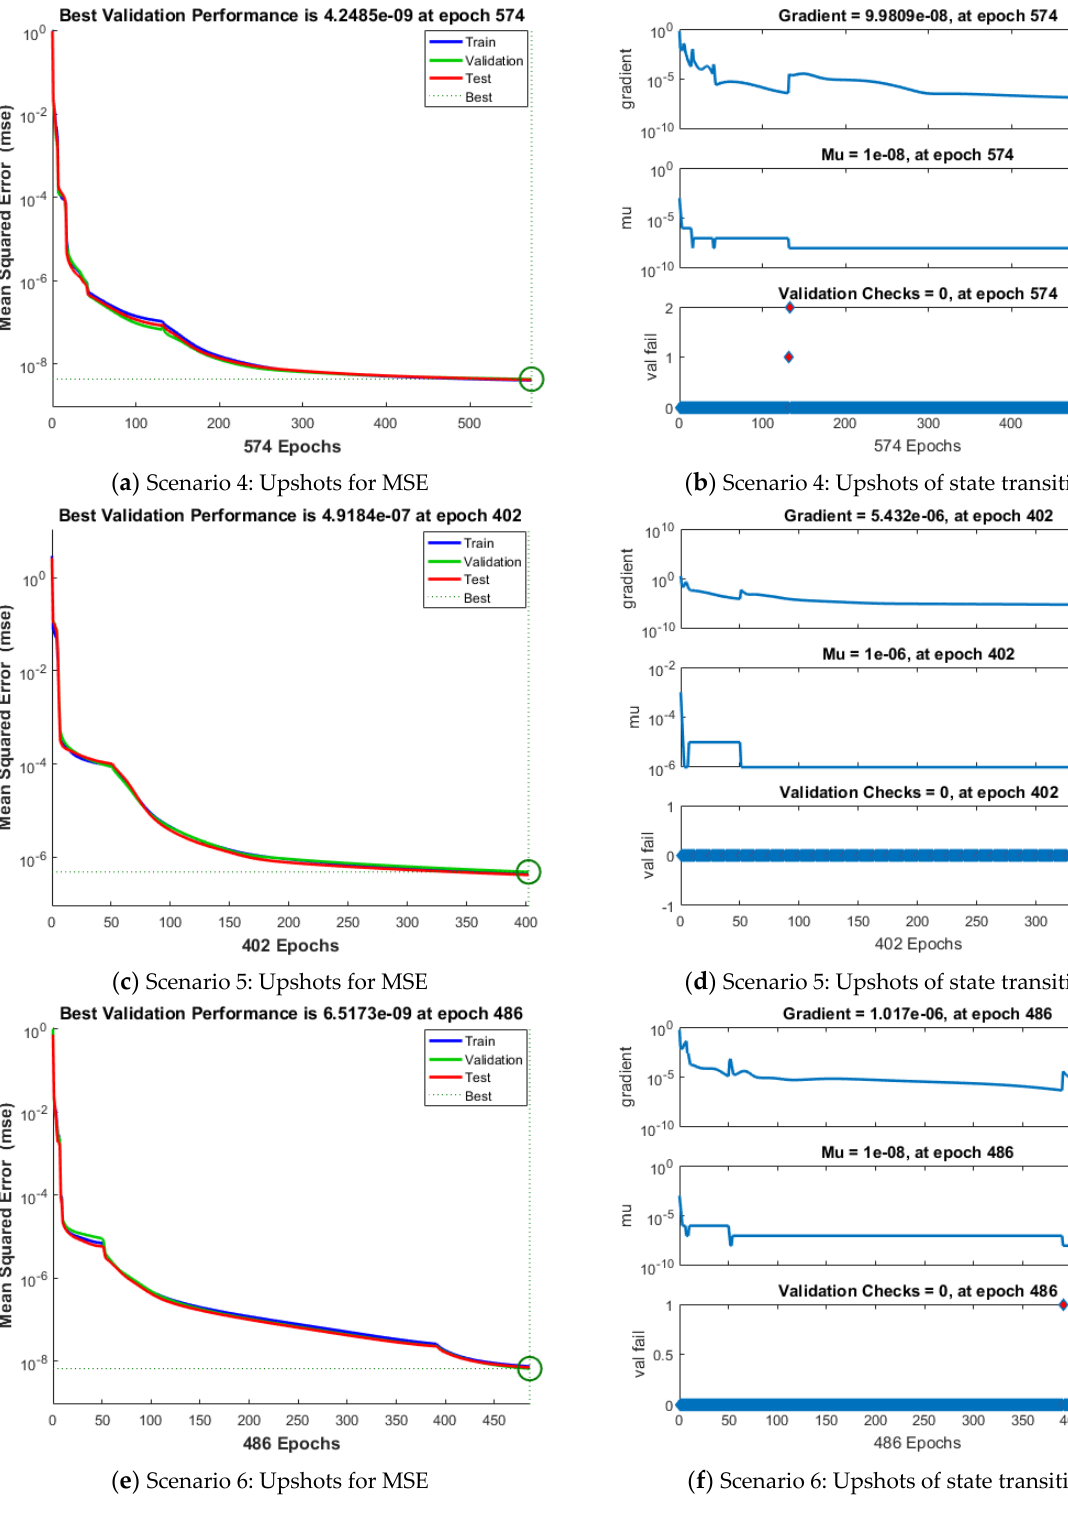
Figure 5. Solution of performance and state transition of proposed TLMB-NN for solving HTM-BFN model with MHD for scenarios 4–6.